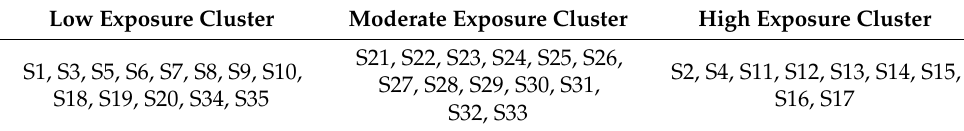
Table 8. Assignment of tourist sites to clusters using the proposed